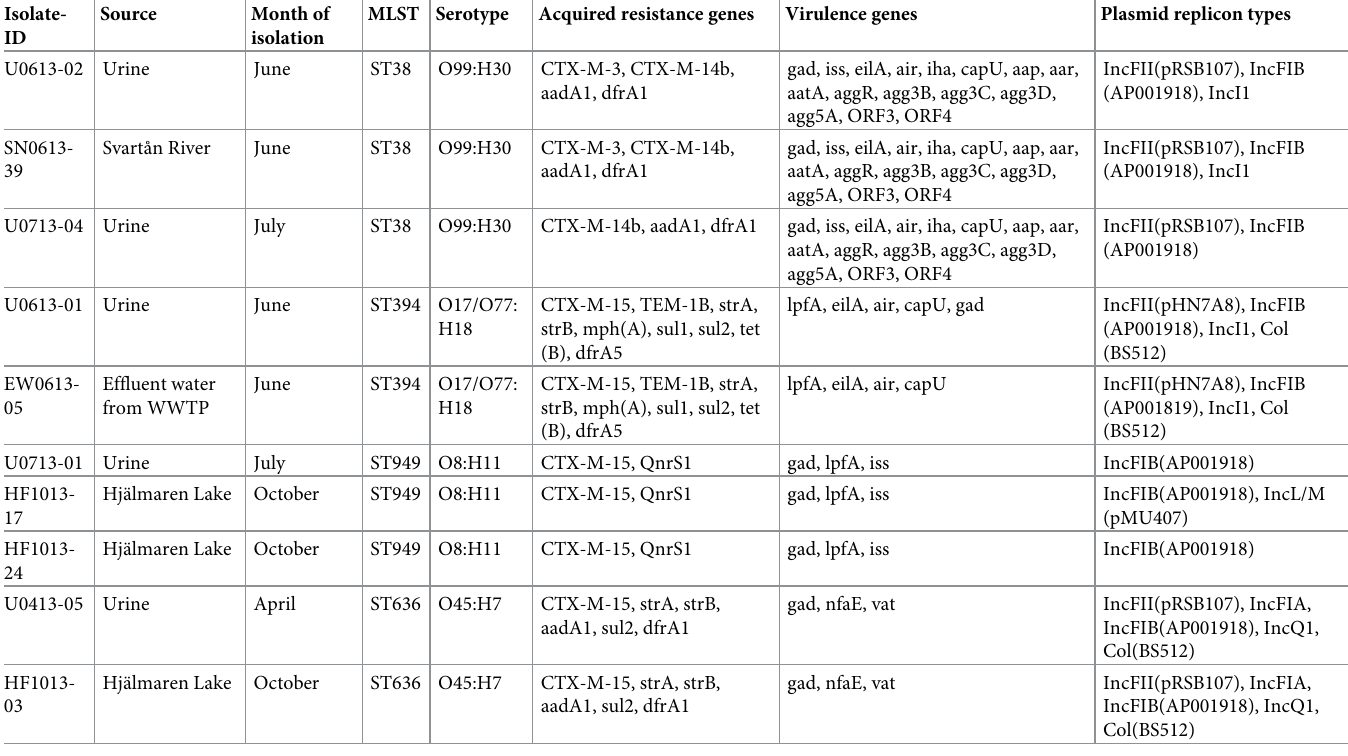
Table 3. Comparison of indistinguishable or closely related isolates based on cgMLST. Isolate-